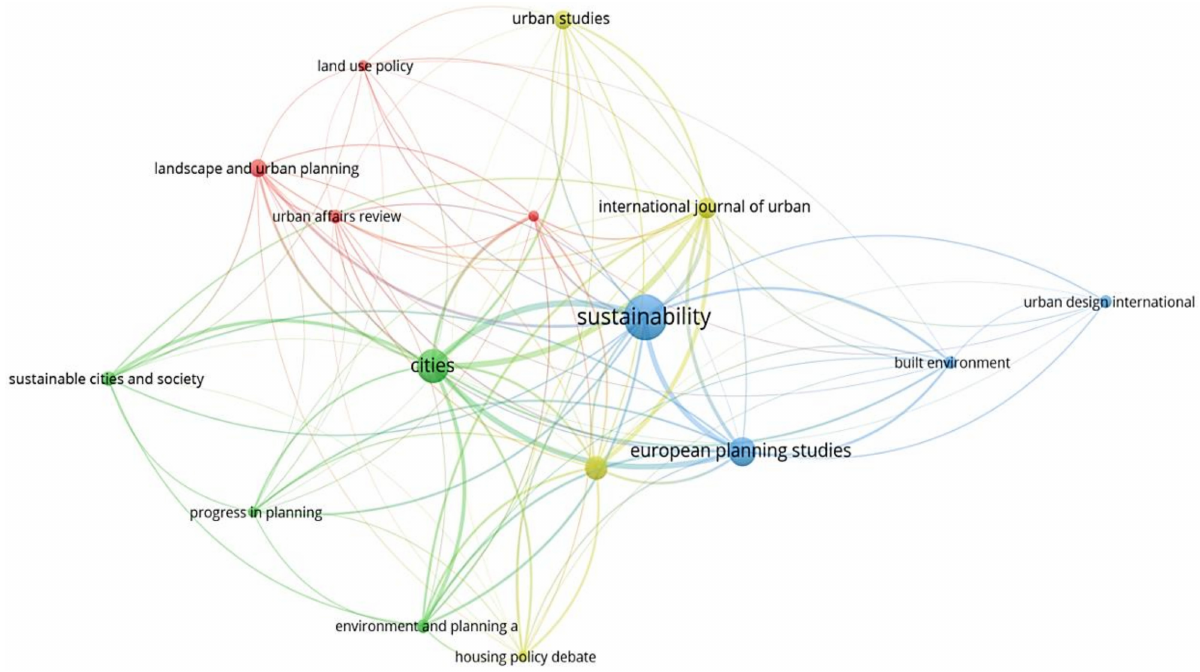
Figure 3. Map of dominant journals in the field of SCT.